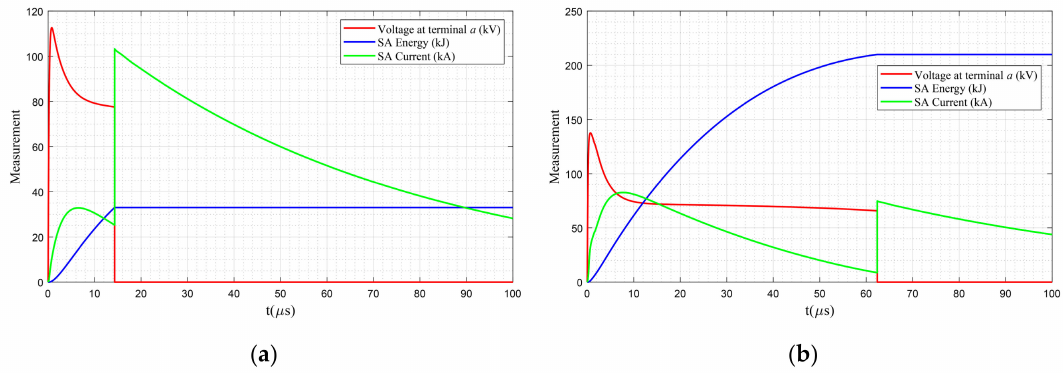
Figure 14. Failure of ( a ) SA-30a under 125 kV lightning impulse and ( b ) SA-30b under 175 kV lightning